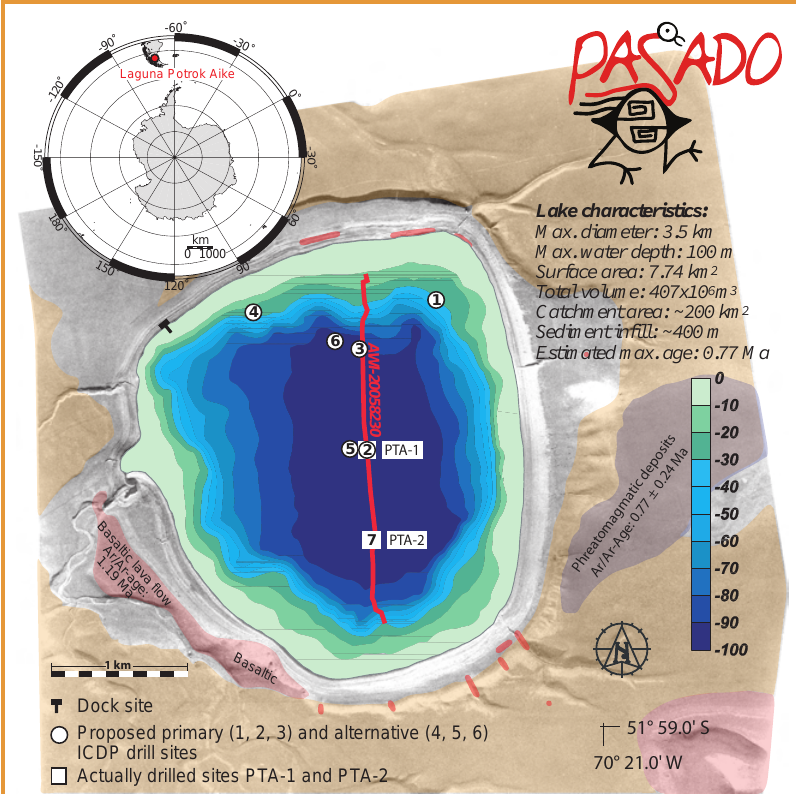
Figure 1. Bathymetric map of Laguna Potrok Aike merged with an aerial photograph and geological data (Corbella, 2002; Zolitschka et al., 2006). Inset map shows the site location in sub-Antarctic South America. Color-coded young fluvial and lacustrine deposits (gray), a mid-Pleistocene basalt lava flow (red), phreatomagmatic tephra deposits (pink), moraine till (yellow), Tertiary Santa Cruz Formation (orange), multi-channel seismic line of Fig. 2 (red line), and planned (numbered white circles) and drilled (numbered and labeled white squares) coring